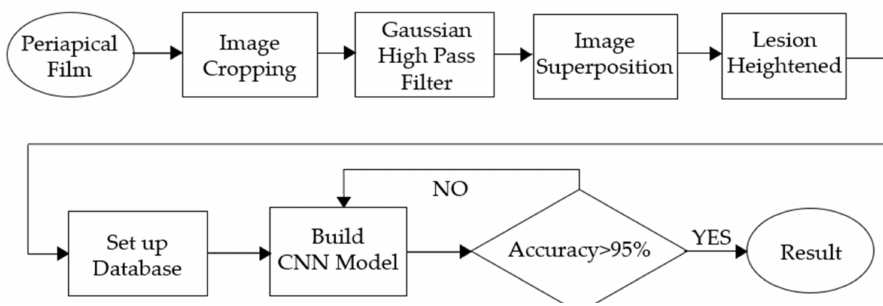
Figure 1. The flow chart of this